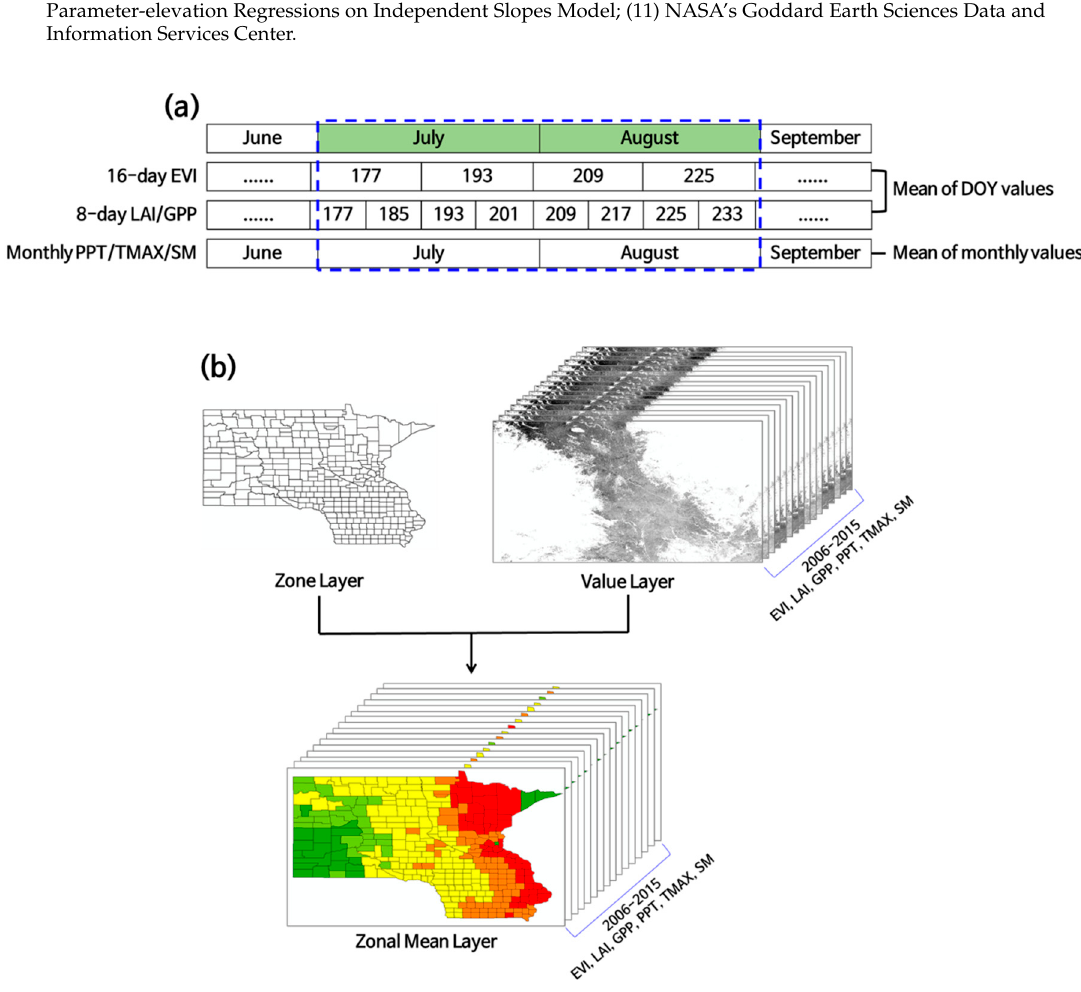
Figure 3. Concept of the ( a ) temporal aggregation for July–August and the ( b ) spatial aggregation using zonal mean operation for the counties of the study area.